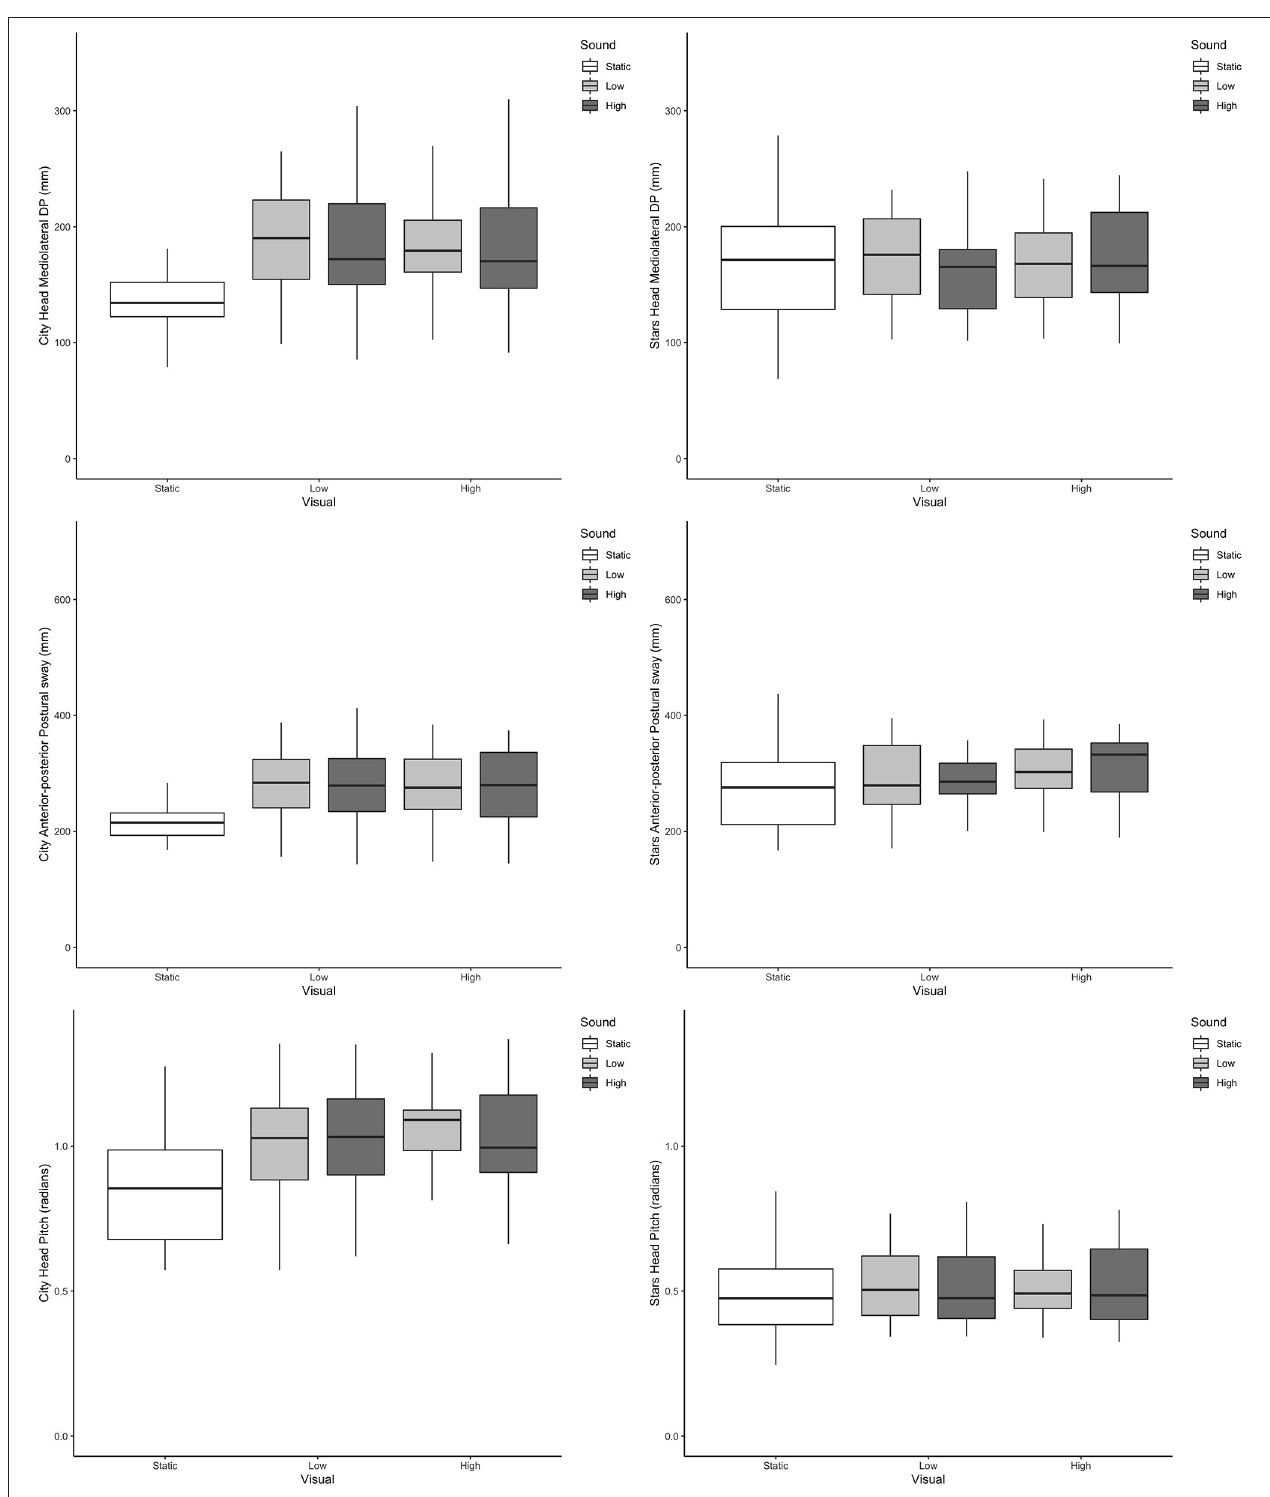
FIGURE 3 | Boxplots of head directional path (Y axis) across the different visual and auditory levels for the city scene (left-hand side) and stars scene (right-hand side) in the medio-lateral direction (top, mm); anterior-posterior direction (middle, mm) and pitch (bottom, radians).